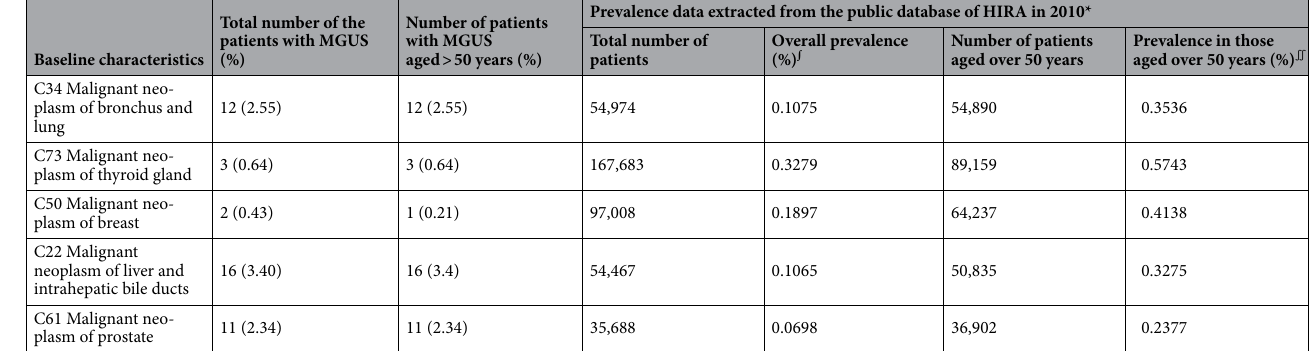
Table 3. Prevalence of comorbidities at the time of MGUS diagnosis. The prevalence of comorbidities at the of MGUS time diagnosis was defined as comorbidities diagnosed from January 1, 2007 to the date for diagnosis of MGUS. *The prevalence data for each comorbidity in the entire population was provided by the public HIRA database, presented as reference data. The prevalence calculation method of each comorbidity in the entire population is presented as a figure legend in Supplementary Figure 1. ∫The overall prevalence was calculated by the following formula: (the total number of patients diagnosed with corresponding disease during the year/ the mid-year population) × 100. ∬ The prevalence among those aged > 50 years was calculated by the following formula: (the number of patients > 50 years diagnosed with the corresponding disease during the year/the mid- year population > 50 years) × 100. ‡ This entry includes all